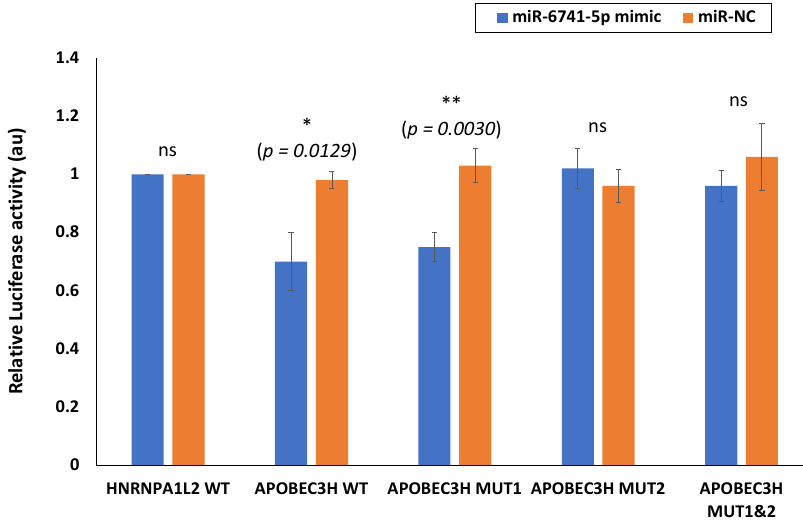
Figure 3. miR-6741-5p specifically binds and interact with APOBEC3H. Luciferase activity in HEK293T cells transfected with pmirGLO dual-luciferase vector with 3 (cid:48) UTR of HNRNPA1L2 (HNRNPA1L2 3 (cid:48) UTR) and APOBEC3H (APOBEC3H 3 (cid:48) UTR). HEK293T cells were transfected with HNRNPA1L2 3 (cid:48) UTR or APOBEC3H 3 (cid:48) UTR, co-transfected with HNRNPA1L2 3 (cid:48) UTR or APOBEC3H 3 (cid:48) UTR and miR-6741-5p mimic, co-transfected with HNRNPA1L2 3 (cid:48) UTR or APOBEC3H 3 (cid:48) UTR and control mimic (miR-NC). We also tested APOBEC3H MUT1 and MUT2 3 (cid:48) UTR in this study. Luciferase activity was monitored at 48 h post-transfection and was normalized against the effect of the miRNAs on the Firefly luciferase reporter alone. The relative luciferase activity for cells transfected with HNRNPA1L2 3 (cid:48) UTR or APOBEC3H 3 (cid:48) UTR is considered as 1 au. The x -axis denotes the UTRs transfected, and y -axis indicates the relative luciferase activity. Bars represent average ± s.d. of three individual experiments. One-way ANOVA was performed compare between multiple groups. p value of 0.05 or less was considered statistically significant. * denotes p = 0.0129; ** denotes p = 0.0030; ‘ns’ denotes not significant at p = 0.05.